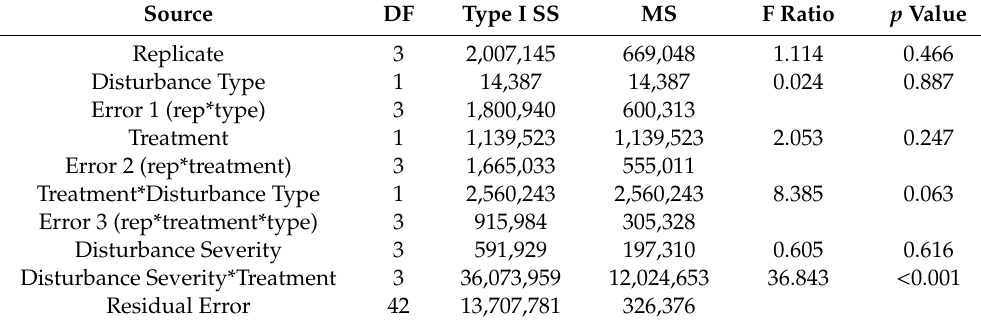
Table A2. Split-plot analysis of variance (ANOVA) table for annual upper canopy (DBH ≥ 8 cm) aboveground wood net primary production (ANPP w ) presented in Figure 4 of the manuscript. Disturbance type and treatment (girdled / not-girdled) main e ff ects and their interaction terms were tested against more conservative error terms to account for restricted randomization, whereas the main e ff ect disturbance severity and its interaction with treatment were tested against the residual error. Asterisks indicate an interaction between two or more parameters.